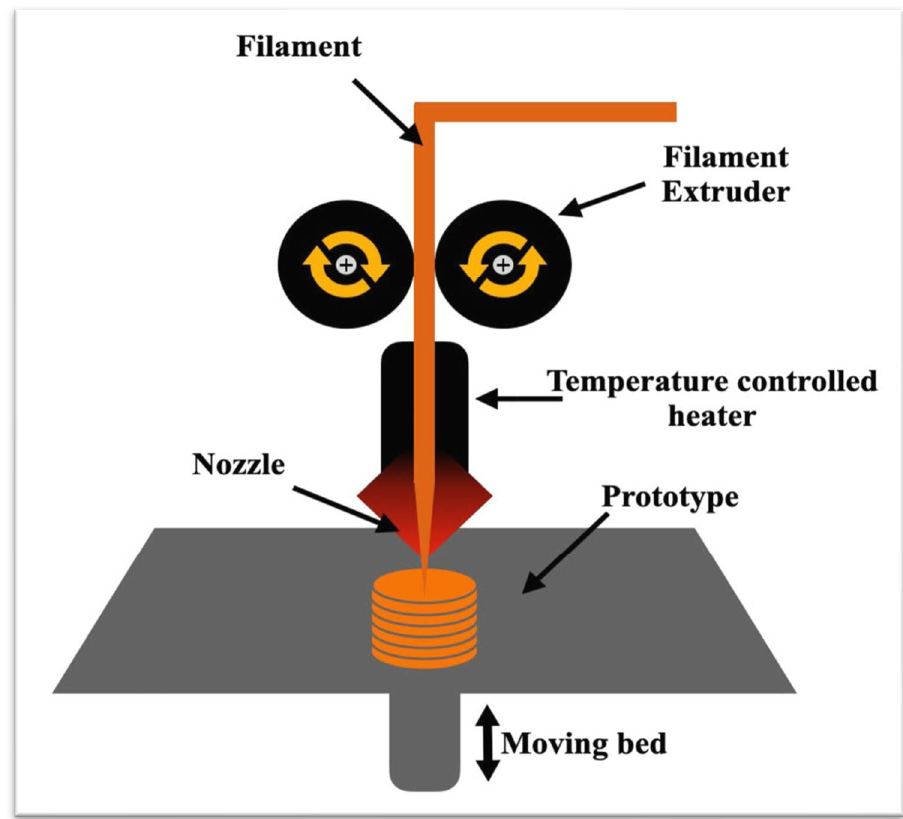
Figure 8. FDM 3D printing (redrawn from Ref.